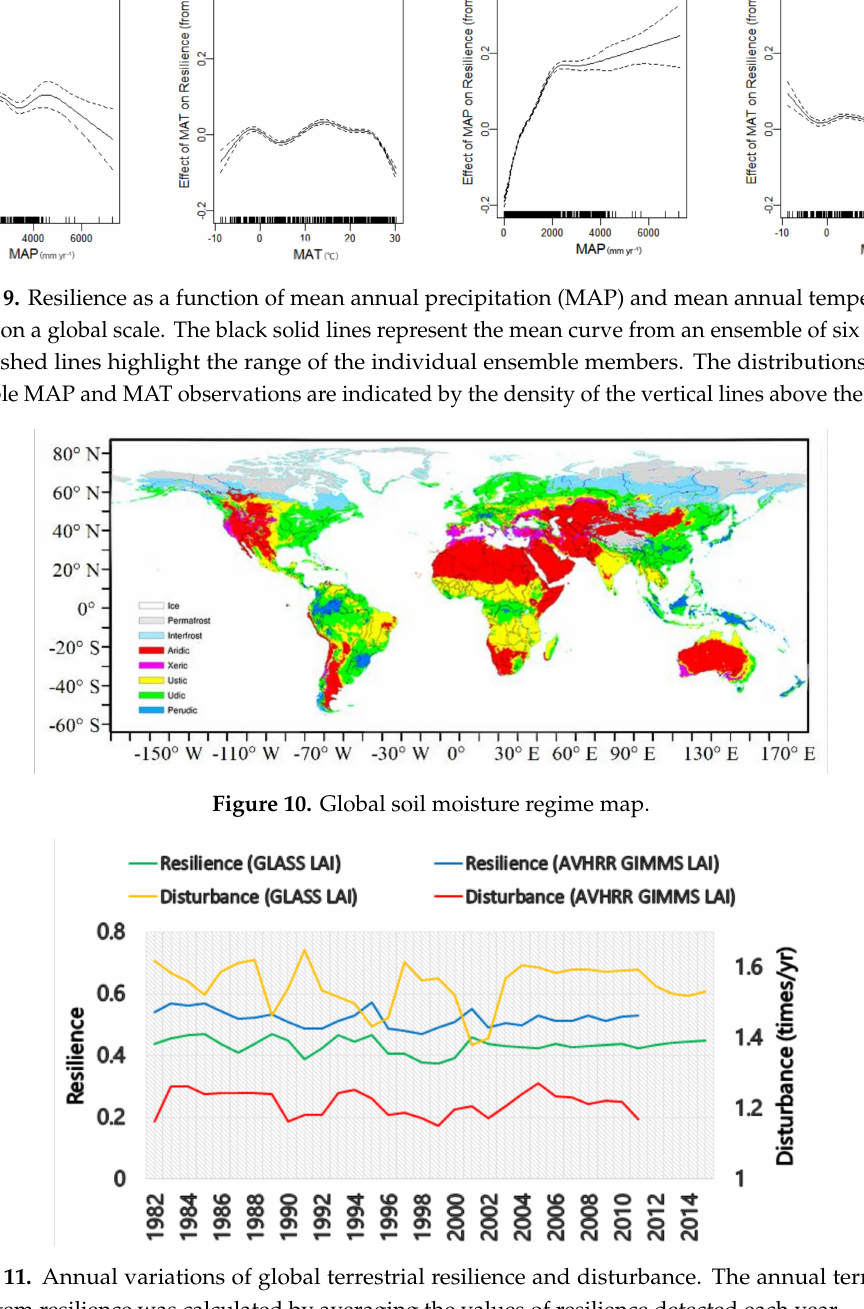
Figure 11. Annual variations of global terrestrial resilience and disturbance. The annual terrestrial ecosystem resilience was calculated by averaging the values of resilience detected each